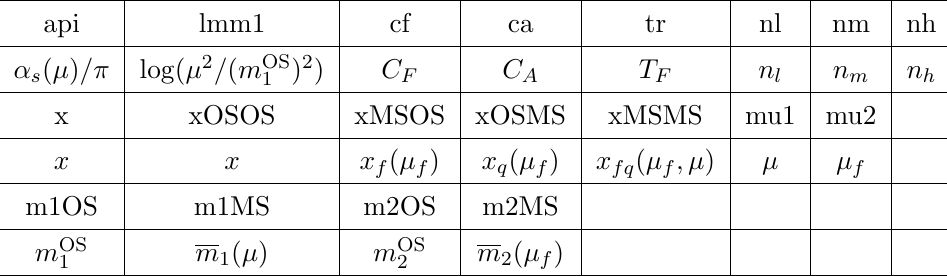
Table 2. Meaning of the symbols used in the Mathematica expressions.